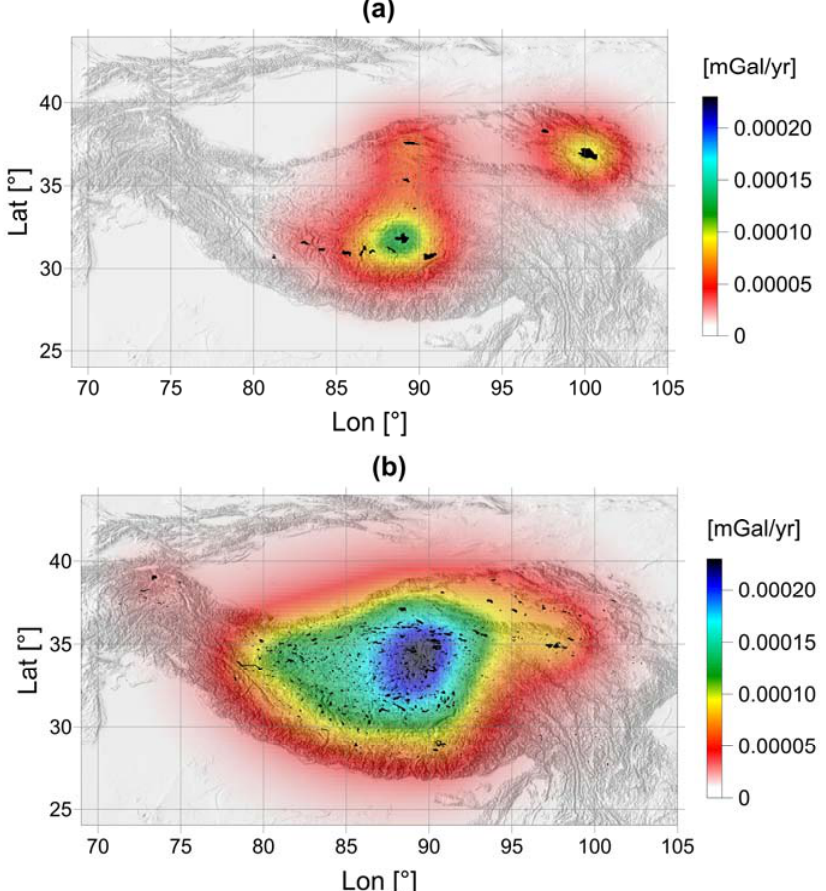
Figure 7. ( a ) Long-period yearly gravity rates due to lake-level variations in the 14 lakes monitored by DAHITI. ( b ) Long-period yearly gravity rates due to lake-level variations in the lakes of the Tibetan plateau not monitored by the DAHITI. Level rate changes are extrapolated from DAHITI. In both maps, the outlines of the lakes considered are reported. Calculation altitude is 250 km.